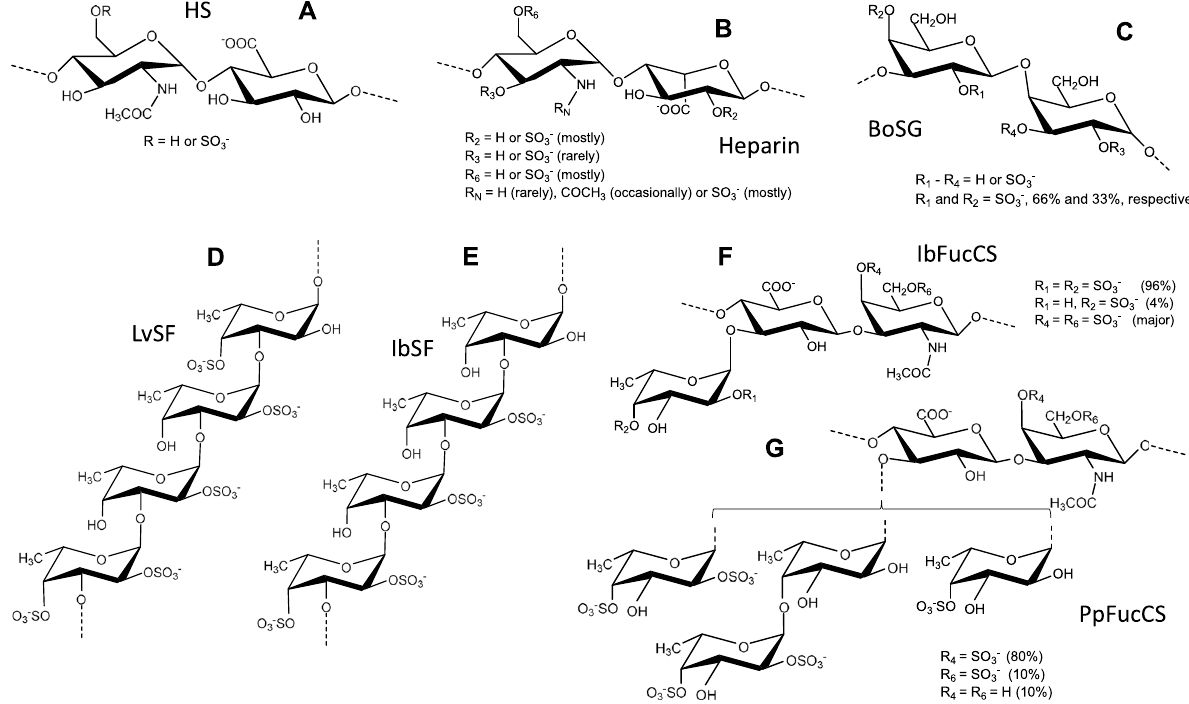
Figure 1. Structural representations of HS, heparin and the five MSGs studied. ( A ) HS is composed of [-4)-N-acetylglucosamine-(α1-4)-glucuronic acid-(α1-]. ( B ) Heparin is composed of [-4)-N,6-disulfated- glucosamine-(α1-4)-2-sulfated-iduronic acid-(α1-] with additional modifications as indicated in the panel. ( C ) BoSG is composed of [-3)-galactose-(β1-4)-galactose-(α1-] n with variable sulfation patterns as indicated in the panel. ( D ) LvSF is composed of [-3)-2,4-disulfated-fucose-(α1-3)-2-sulfated-fucose-(α1-3)-2-sulfated- fucose-(α1-3)-4-sulfated-fucose-(α1-] n . ( E ) IbSF is composed of [-3)-2,4-disulfated-fucose-(α1-3)-2-disulfated- fucose-(α1-3)-2-sulfated-fucose-(α1-3)- fucose-(α1-] n . ( F ) IbFucCS is composed of {-4)-[ fucose-(α1-3)]- glucuronic acid-(β1-3)-N-acetylgalactosamine-(β1-} with variable sulfation patterns as indicated. ( G ) PpFucCS is composed of {-β3)-N-acetylgalactosamine-X-(β1-4)-glucuronic acid-[(3–1)-Y]-(1-}, where X = 4S (80%), 6S (10%) or non-sulfated (10%), Y = α-Fuc2,4S (40%), Fuc2,4S-(α-1–4)-α-Fuc (30%), or α-Fuc4S (30%), and S = SO 3 − , as indicated in the